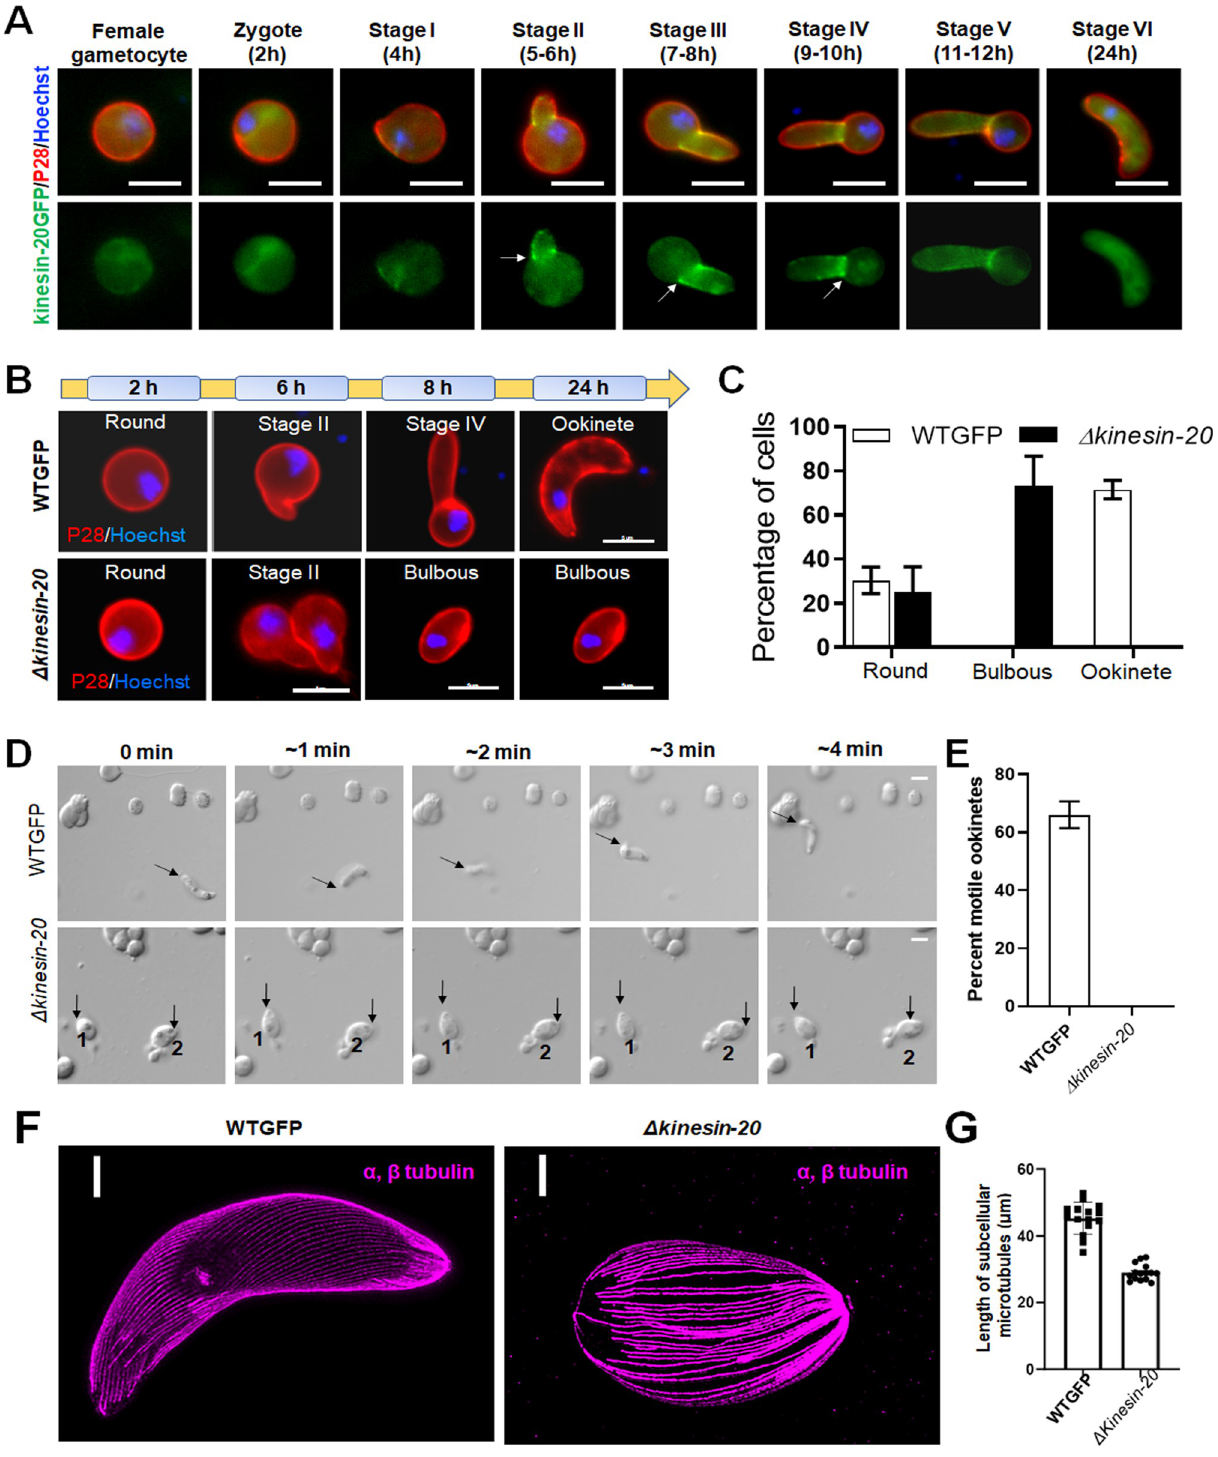
Fig 3. Kinesin-20 makes a ring-like structure at the base of developing ookinete and is important for zygote to ookinete transformation and subsequent motility. (A) Live cell imaging showing localisation of kinesin-20GFP (green) in the female gametocyte, zygote, and during ookinete transformation. Kinesin-20GFP accumulates at the neck of developing ookinete making a ring-like structure (indicated by arrows). Labelling with P28 was used to identify the surface of activated female gametes, zygotes, and ookinetes and to mark these stages (red). DNA is labelled with Hoechst dye (blue) (B) . Ookinete developmental stages for Δ kinesin-20 and WTGFP parasites. Ookinetes were identified using P28 and defined as those